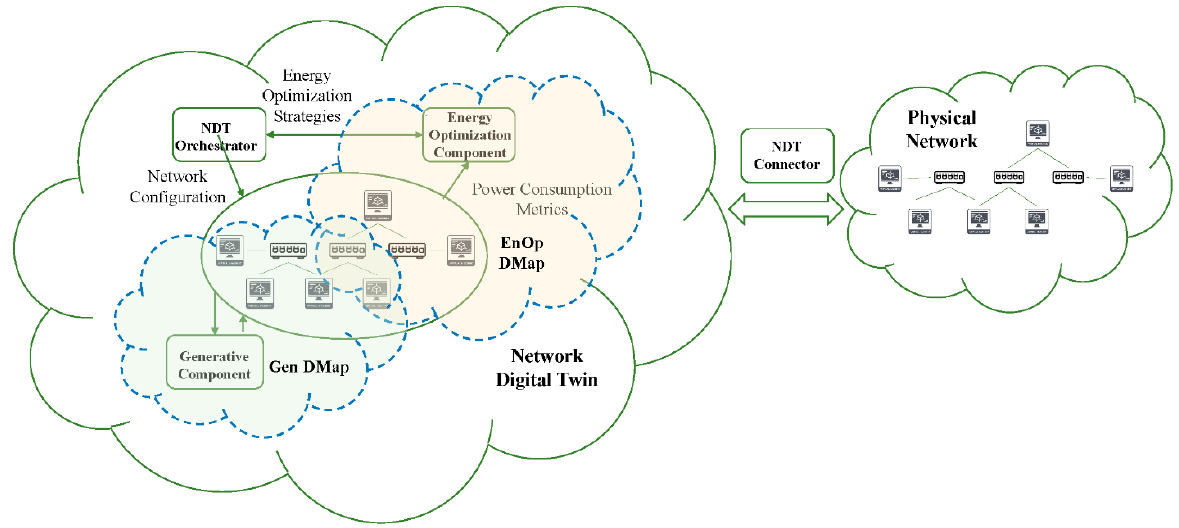
Figure 7. An illustration of the DMap ‐ based NDT solution for the energy optimization use case.